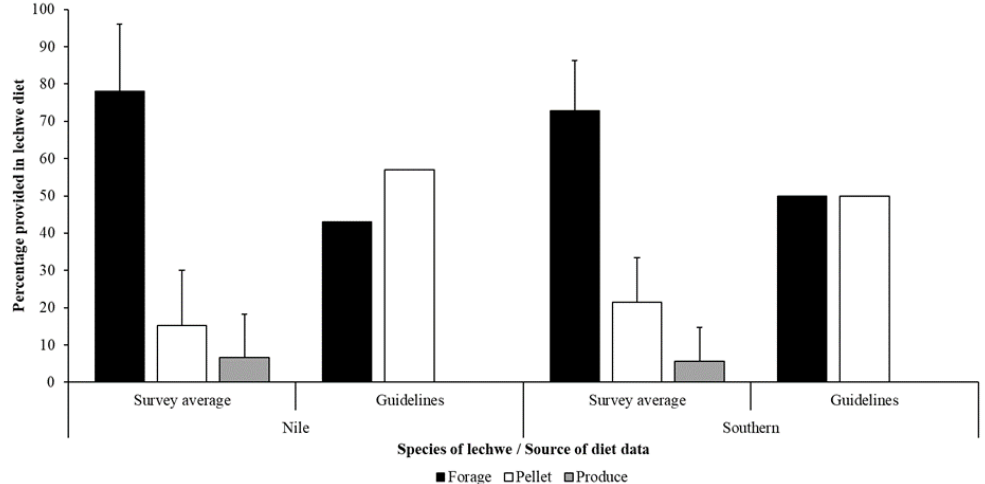
Figure 2. The average (mean plus standard error) for all data on proportion of forage (black), pellets (white) and produce (grey) for Nile (left) and southern (right) lechwe in the surveyed population compared to the suggested proportion of forage and pellets for Kobus antelope species available in the 1999 AZA published guidelines.